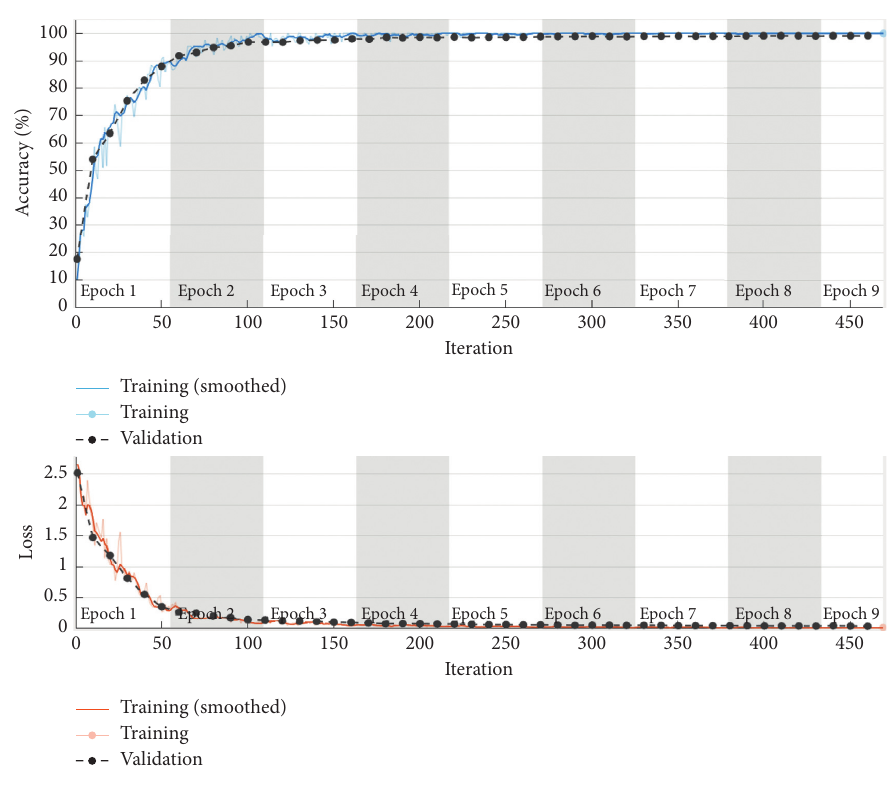
Figure 6: Iteration diagram of training and testing